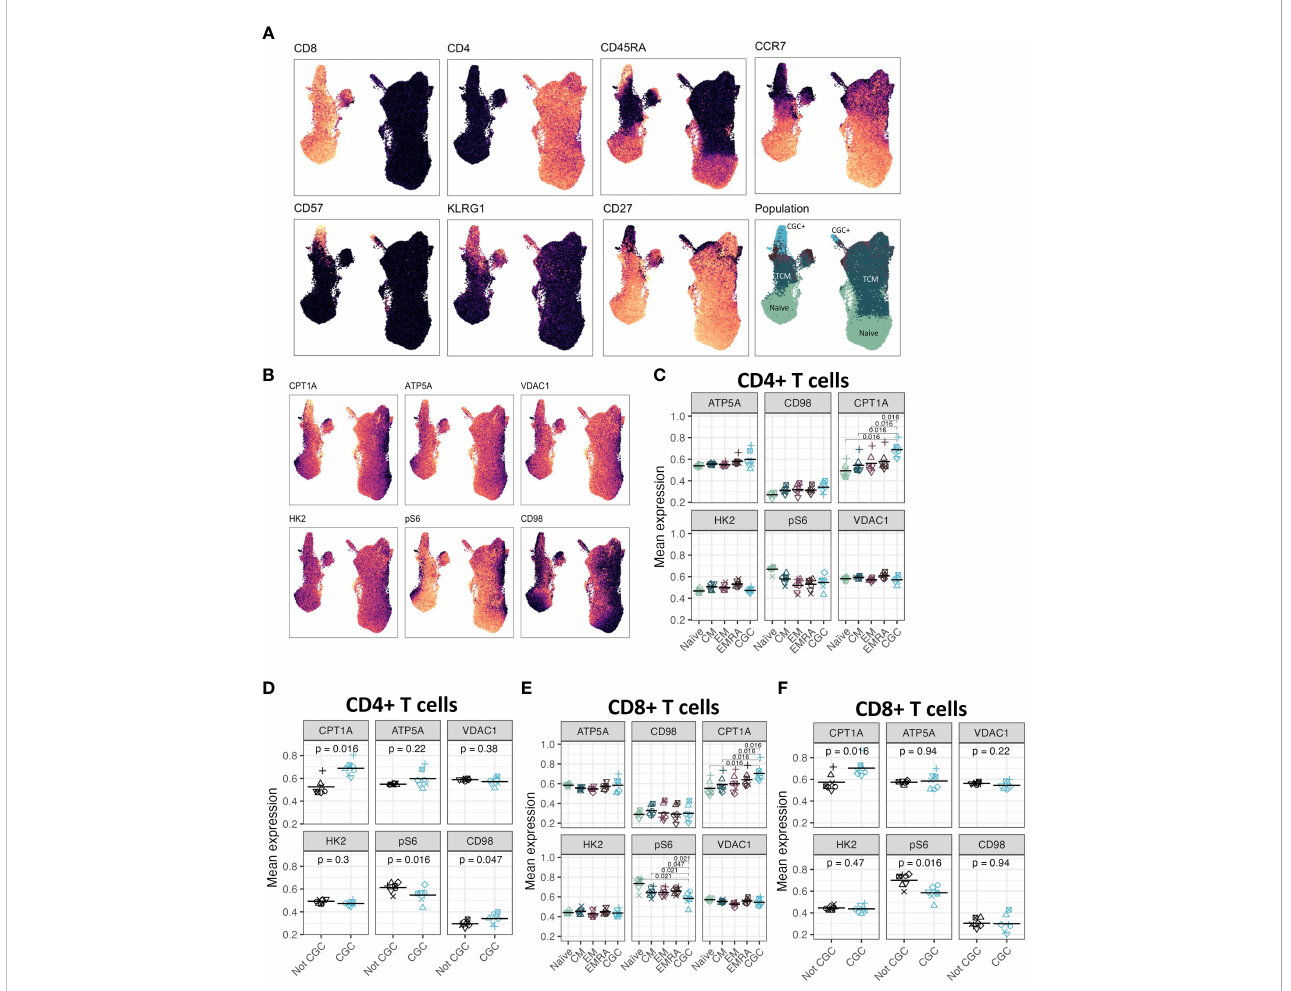
FIGURE 12 CGC + CD4 + T cells have higher expression of carnitine palmitoyl transferase (CPT1A), a rate-limiting enzyme of fatty acid oxidation. UMAPs showing markers used to de fi ne the CGC + T cells (CD28 - KLRG1 + CD27 - ) (A) . CPT1A, ATP5A, VDAC1, HK2, pS6, and CD98 expression were measured by mass cytometry (B) . Dot plots show the expression of each of the metabolic markers between CD4 + naive, central memory (CM), effector memory (EM), TEMRA (EMRA), and CGC T cells (C) , as well as a comparison of CGC + CD4 + T cells and non-CGC + T cells [every other CD4+ T cell] (D) . A similar analysis is shown with CD8 + T cell subsets (E, F) . Statistical analysis (C, E) was performed using pairwise comparisons between the CGC subset and each of the other four populations for each marker, followed by local FDR for multiple hypothesis correction within each marker for the four population comparisons. We only show comparisons with q value<0.05. Statistical analysis of (D, F) was by paired Wilcoxon signed rank test, with no multiple hypothesis